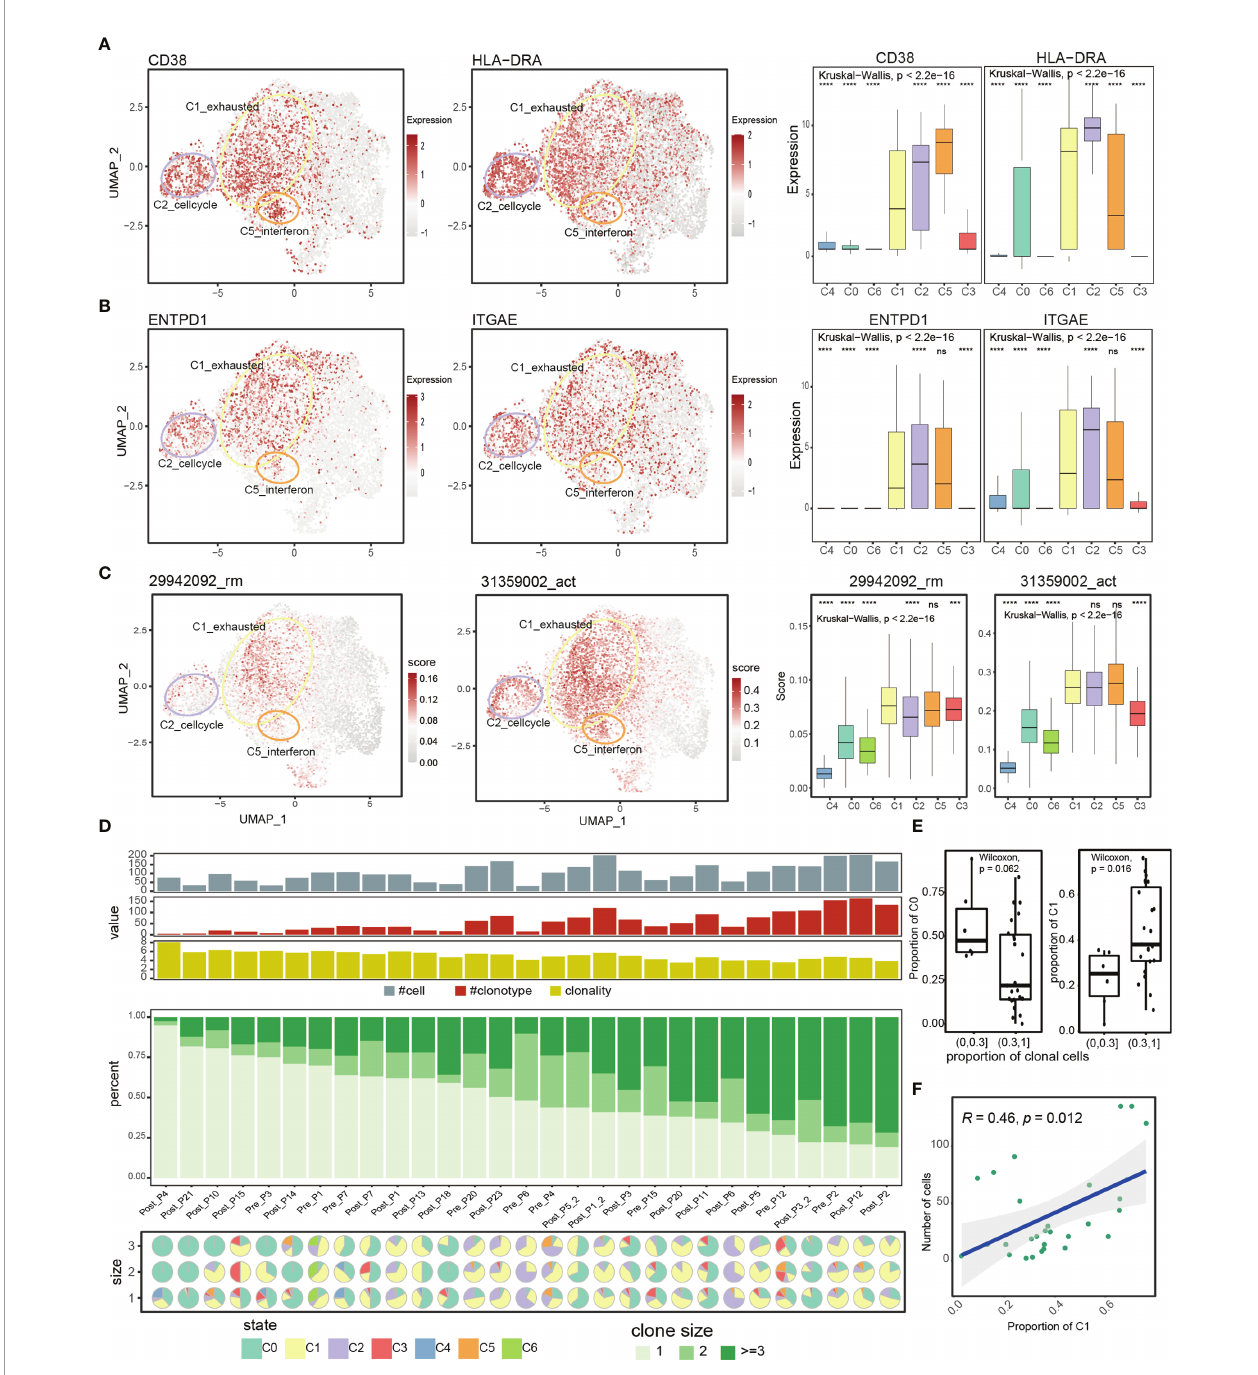
FIGURE 2 | Comprehensive transcriptional analysis and T cell receptor analysis reveals enrichment of tumor-reactive CD8+ T cells in the C1_exhausted T cell state. (A, B) UMAP feature plot representation of T cell activation markers (CD38, HLA-DRA) and tumor reactive markers (ENTPD1, ITGAE) within individual T cell state. Boxplots showing the signi fi cance of the expression difference among T cell state. (C) UMAP feature plot representation of AUCell scores of T cell reside memory signatures and T cell activation signature within individual T cell state. Boxplots showing the signi fi cance of the expression difference among T cell state. (D) Clonal composition of T cells in each patient showing from top to bottom the number of T cells of which the TCR was retrieved, the number of clonotypes, the clonality score (de fi ned by Shannon Entropy), the composition of clone size (size=1, size=2, and size>2), and the pie charts showing the cell states composition of each patient strati fi ed by clone size. Patients are ordered by the proportions of size-one clones decreasingly. (E) The difference of cluster C0/C1 proportion between two sample groups, with high and low proportions of clonal cells. (F) Spearman correlation between the fraction of cells in C1_exhausted state and number of cells with TCRs across patients. ns denoted non-signi fi cant, *** denoted p < 0.001, and **** denoted p <